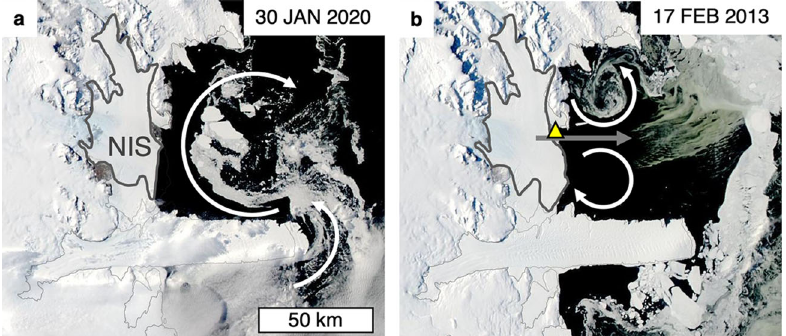
Fig. 2 Terra Nova Bay circulation. MODIS imagery (NASA Worldview) of TNB shows the signature of surface currents (white arrows) in sea ice. a Typical summertime anticyclonic gyre within TNB driven by the de fl ection of the coastal current around the DIT. b Summertime submesoscale eddies produced by strong westerly wind (grey arrow) off the NIS (grey outline) over Inexpressible Island (yellow triangle).